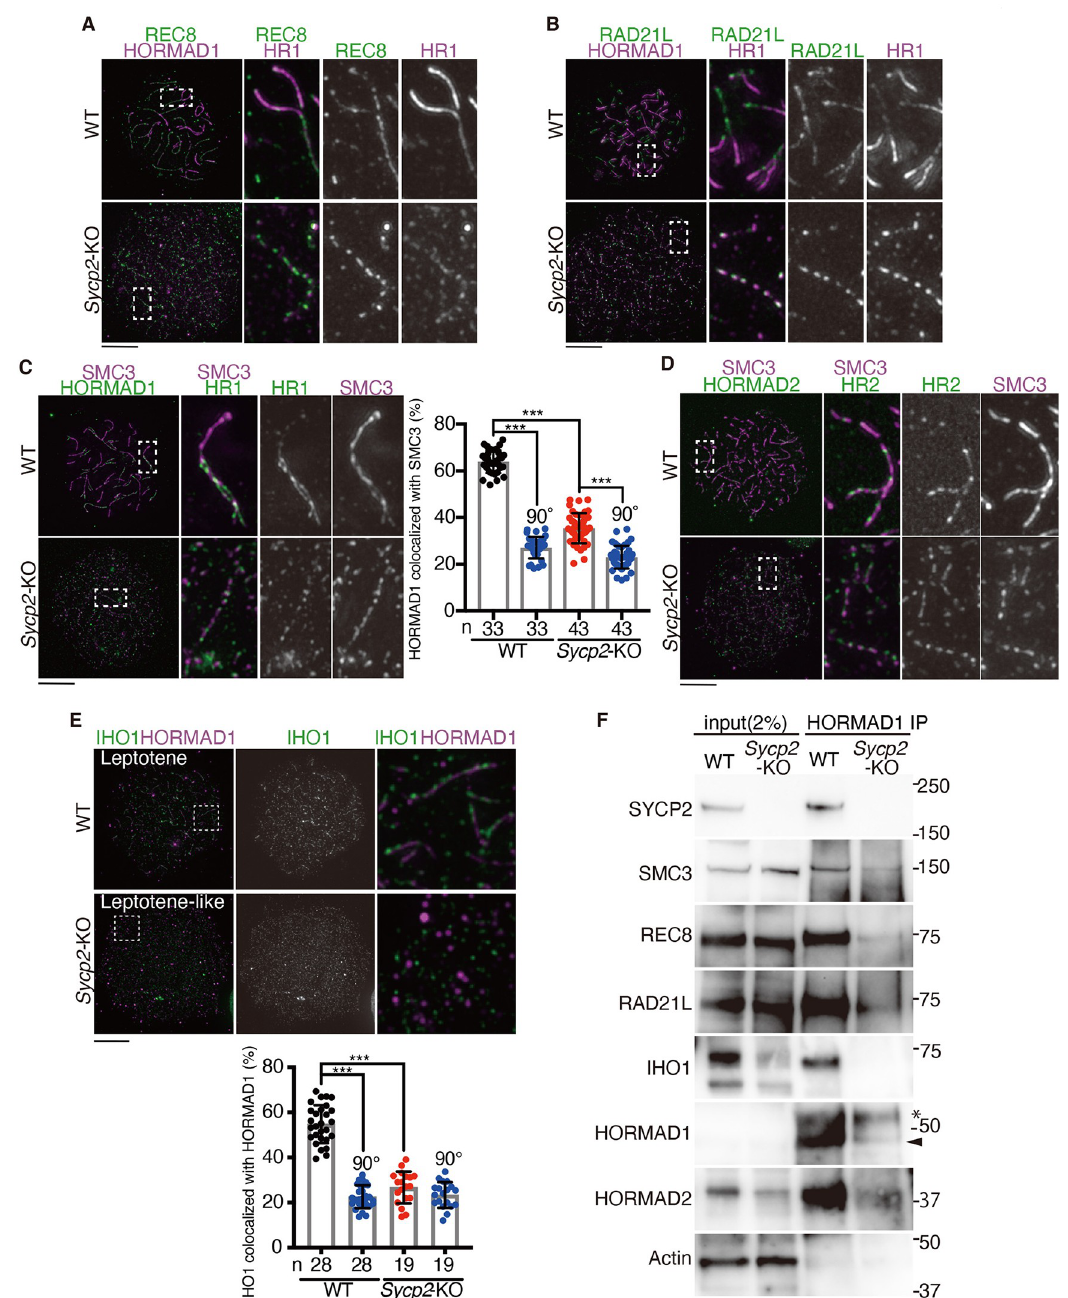
Fig 3. HORMAD1 localized along the cohesin axial cores in the absence of SYCP2. (A) Chromosome spreads of WT and Sycp2- KO spermatocytes were stained for HORMAD1 and REC8. Enlarged images are shown on the right. (B) Chromosome spreads of WT and Sycp2- KO spermatocytes were stained for HORMAD1 and RAD21L. Enlarged images are shown on the right. (C) Chromosome spreads of WT and Sycp2- KO spermatocytes were stained for SMC3 and HORMAD1 (upper). Enlarged images are shown on the right. Co-localization of HORMAD1 with SMC3 was quantified by counting HORMAD1 staining within 5 pixel distance from SMC3 threads. n: number of cells examined. To assess random overlaps, the co-localization was measured without (black and red plots) or with (blue plots) rotation of the HORMAD1 image by 90˚ clockwise relative to the SMC3 image. Statistical significance was assessed by one-way ANOVA followed by Turkey’s multiple comparisons test with a single pooled variance. ��� : P < 0.001. (D) Chromosome spreads of WT and Sycp2- KO spermatocytes were stained for SMC3 and HORMAD2. (E) Chromosome spreads of WT and Sycp2- KO spermatocytes were stained for IHO1 and HORMAD1 (upper). Enlarged images are shown on the right. Co-localization of IHO1 with HORMAD1 was quantified as in (C). (F) HORMAD1-immunoprecipitates